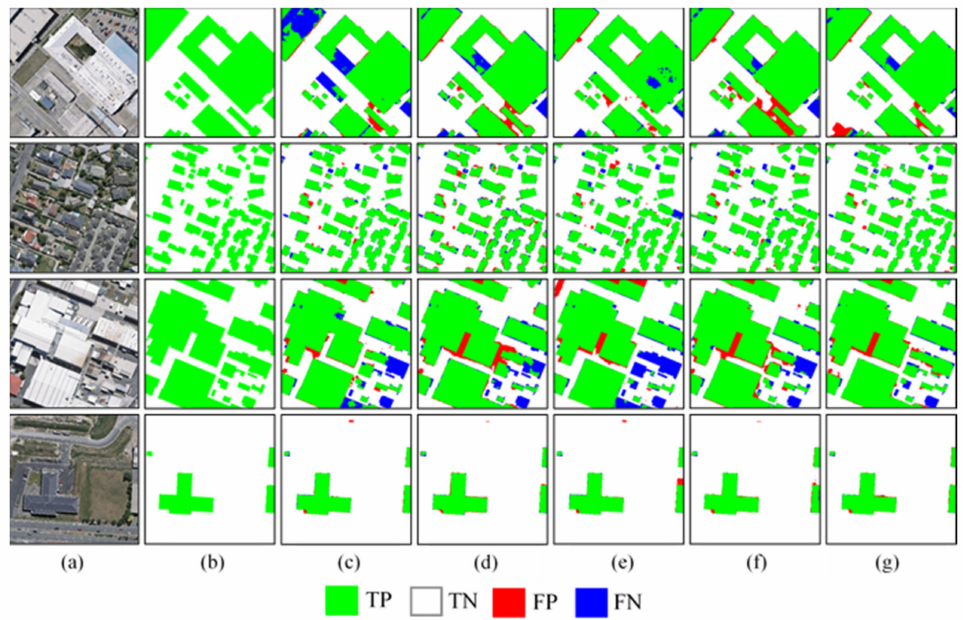
Figure 9. Results of building footprint segmentation on the WHU dataset. ( a ) Images. ( b ) Labels.